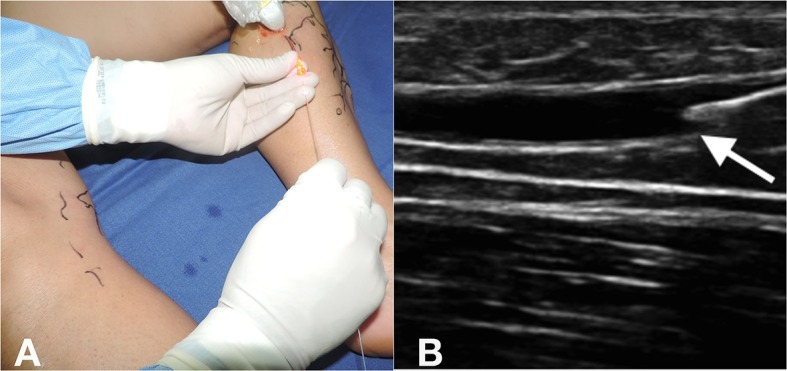
Ultrasound-guided puncture (A) and placement of bare fiber (B).